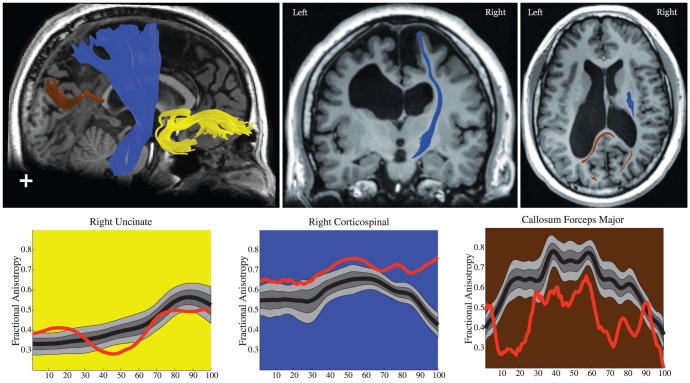
T1 images, tractography results and Tract FA Profiles for Patient 1, a child with ventricular dilatation.In the plots, the black line represents the mean FA for typically developing children at 100 points along the tract and light gray region represents the boundaries for the 10th to 90th percentile. The red line represents the patient's FA along the tract. The patient has variable FA in the uncinate, increased FA along the corticospinal tract and decreased FA in the corpus callosum forceps major.